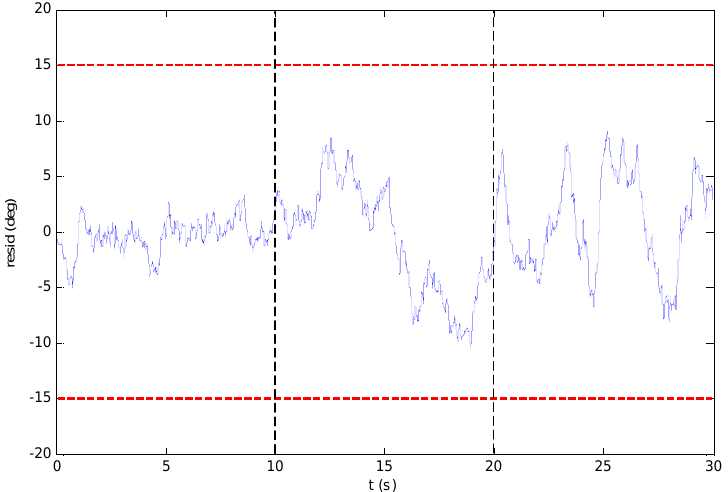
Figure 4. CUSUM filtered residual of GVIRT and